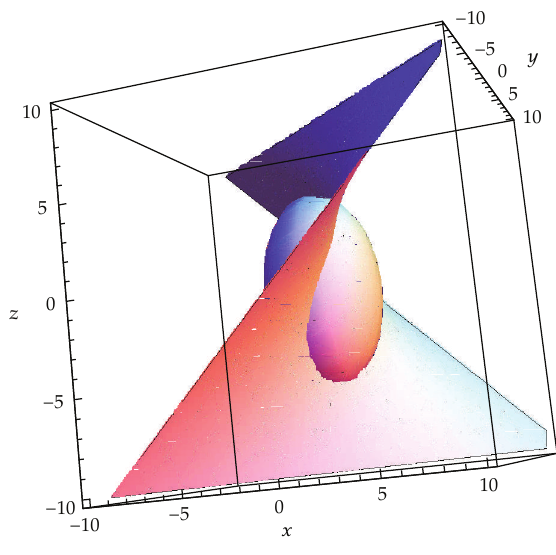
Figure 1: The phase curves of the system (cid:7) 3.8 (cid:8) (cid:7) c 1 (cid:6) 1, c 2 (cid:6) 2, c 3 (cid:6) 3, and k (cid:6) 10 (cid:8)